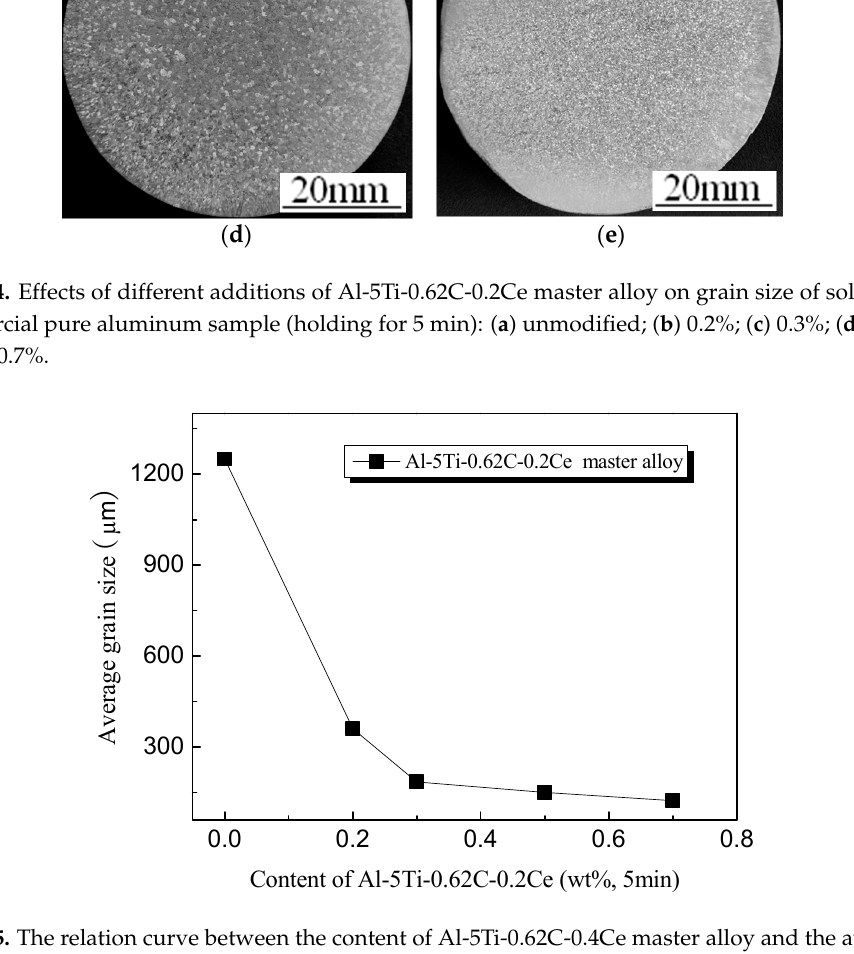
Figure 5. The relation curve between the content of Al-5Ti-0.62C-0.4Ce master alloy and the average size of solidified commercial pure aluminum samples.